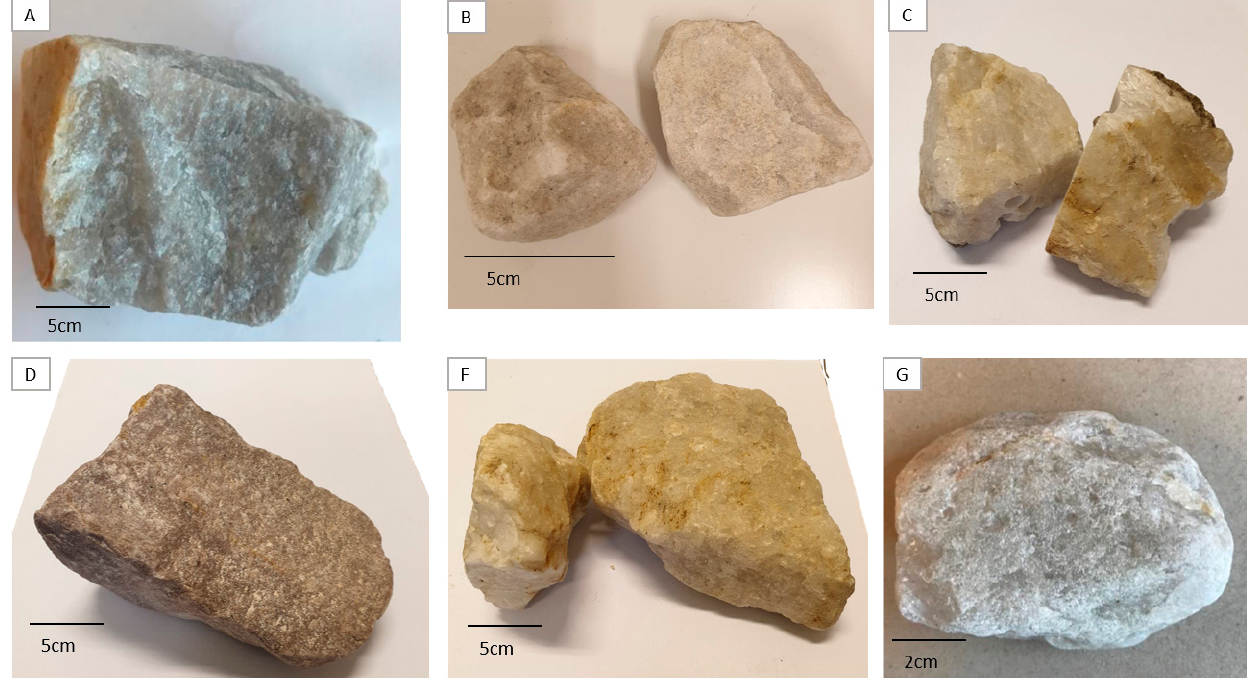
Figure 1. Pictures of the quartz types used in this study: ( A , B , C , D , F , G ), used as raw material in Si and FeSi